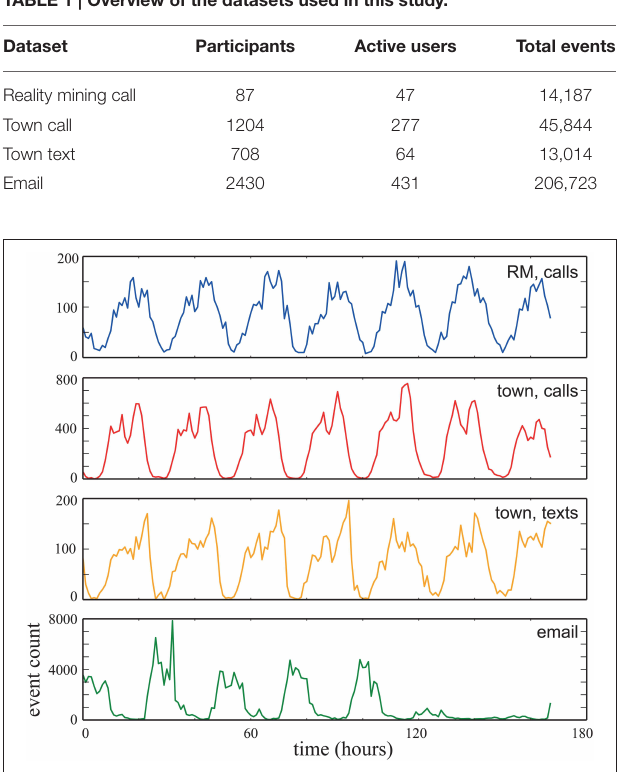
FIGURE 2 | The daily pattern in each of the datasets, computed as an average over all Wednesdays in the data. Colors are the same as in Figure 1 . We observe distinct patterns across the various data channels. Email activity is early in the day, whereas (unobtrusive) text messages peak late at